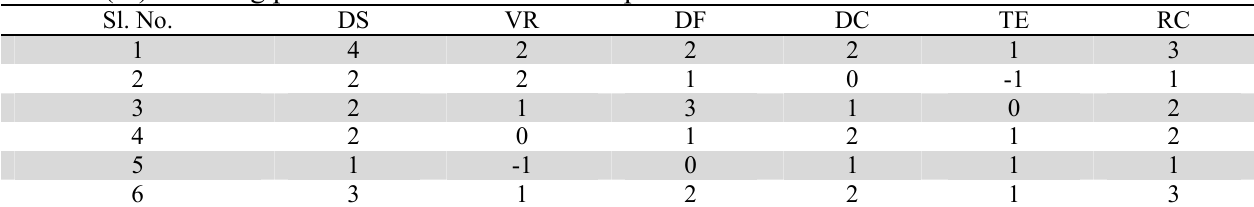
Matrix ( S 2 ) at slicing parameter θ 2 = 0.20 for example 3 Sl.